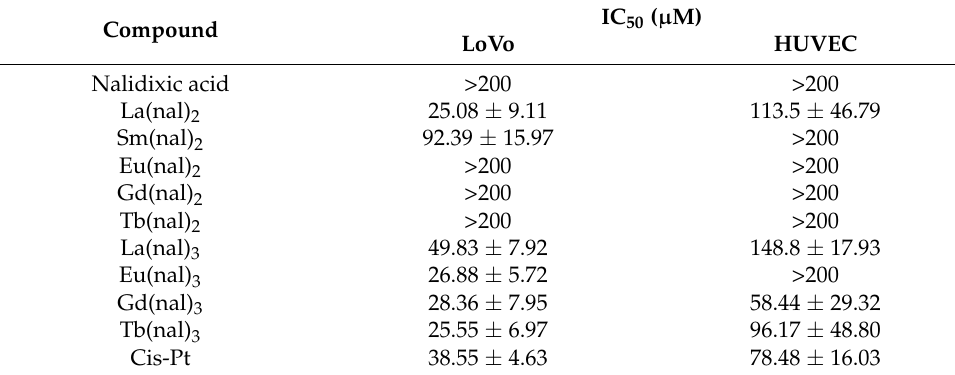
Table 1. IC 50 values ( µ M) for nalidixic acid, M(nal) 2 , M(nal) 3 and cisplatin